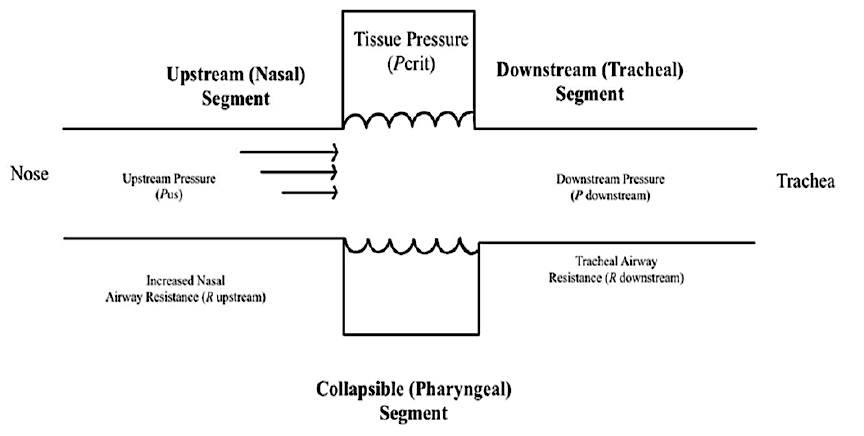
Figure 2. The Starling Resistor Model is a diagram that assists with the explanation of upper airway dynamics and the management of obstructive sleep apnea. The oropharynx is presented as a collapsible tube. Increased nasal airway resistance increases the probability that pharyngeal pressure will decrease below the CRITICAL pressure (Pcrit) and close the pharynx, which is a large proponent of obstructive events. Adapted from Pham & Schwartz [2].